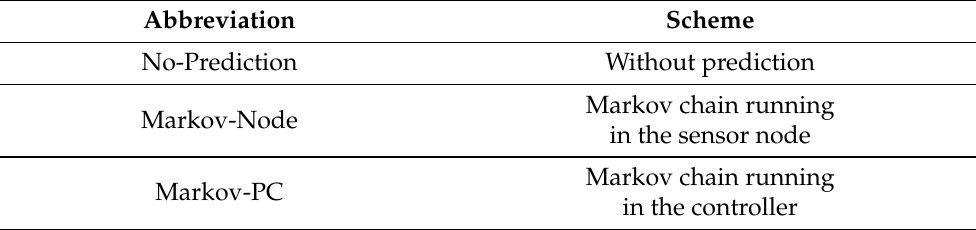
Table 6 represents the cost per transitions in microjoules, i.e., matrix B in Equation (3). The cases with cost zero are transitions that never occurred or that we were not able to mea- sure with our equipment. Last, according to our tests, the initial state is always Processing. Thus, the initial vector X 0 = [ 0 1 0 0 0 ] . Table 3. Abbreviations for the schemes simulated.